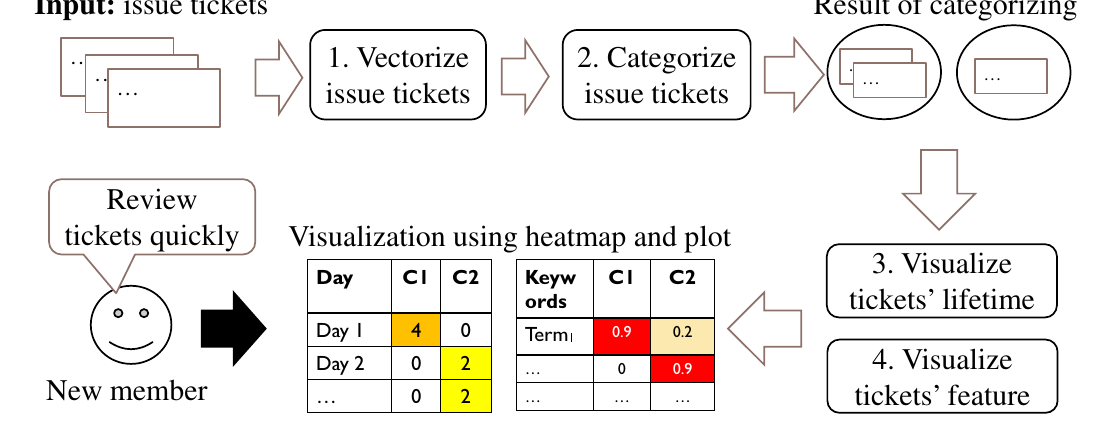
Figure 1. Overview of our